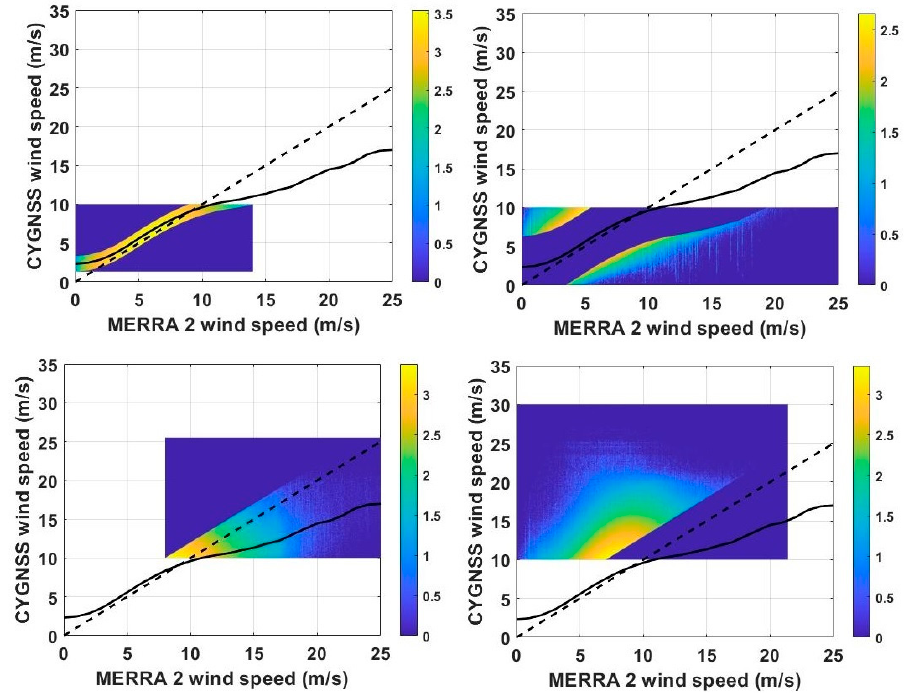
Figure 2. Density plot of CYGNSS Level 2 retrieved winds matched to MERRA-2 reference winds used for training. Top row represents the good (left) and outlier (right) training population for (0 < U CYG <= 10 m / s). The bottom row represents the good (left) and outlier (right) training population for ( U CYG > 10 m /